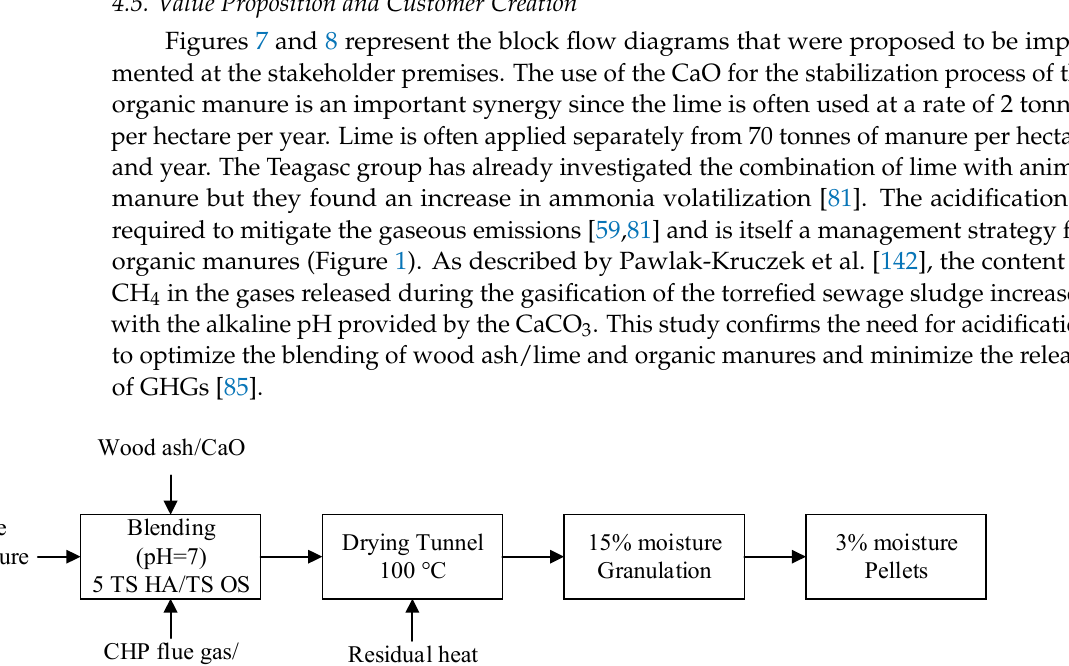
Figure 8. Proposed process B to be implemented directly at the anaerobic digestion plant of one of the stakeholders of the OWAS project. Both processes, A (Figure 7) and B (Figure 8), were developed as part of a business plan that require lower capital investment for validation, compared to the modified wood pellet boiler for stabilization of animal manure, slurry, and digestate (Figure 4). Already- patented technology by Garrido and Crutchick [114] for simultaneous nutrient recovery and granulation due to the shear force of the circulating fluid proves the technical viability of this equipment (Figure 4) and the degree of competitiveness of the market of organic waste valorization. Using the design thinking methodology [143], a simplified prototype was built and consisted of a closed system where the moisture of the organic amendment is stripped by the CaCl 2 , which is a hygroscopic salt that can be used as desiccant [144]. In this way, the losses of nitrogen via volatilization of NH 3 will be minimized and the organic manure will preserve all its properties. Furthermore, the acid solution of CaCl 2 captures the ammonia in the headspace, as could be told by the smell of the aqueous solution. This route should be more economically favorable than using conditions to promote the NH 3 stripping off the organic amendment [145,146]. The financial study for the creation of the profitable start-up was performed according to the guidelines provided by the Galician Institute of Economic Promotion [147]. Considering the subsidies available, an initial in- vestment around GBP 20,000 would be required for the creation of an enterprise, which will be able to commercialize the chemical technology and generate profits from the sec- ond year onwards (Figure 9).